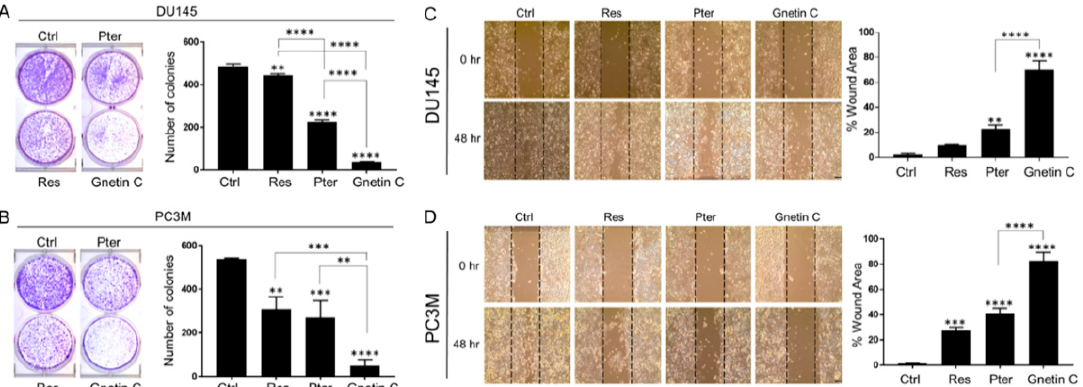
Figure 3. Gnetin C reduces clonogenic survival and motility in DU145 and PC3M prostate cancer cells more potently than Res and Pter. ( A , B ) Representative images ( left ) and quantification ( right ) of the number of colonies showing colony formation ability of prostate cancer cells after treatment with 5 µ M of compounds for 14 days. Data represent the mean ± SEM of three independent experiments with duplicate wells. ** p < 0.01; *** p < 0.001; **** p < 0.0001 (one-way ANOVA). ( C , D ) Representative images ( left ) and quantification ( right ) of the migration ability of cells after treatment with 1 µ M of compounds for 48 h. Values of vehicle-treated Ctrl cells at 0 h were assigned as 100%, and the percentage of wound area of compound-treated cells was calculated on that base. 10X images (scale bar, 100 µ m). Data represent the mean ± SEM of six separate wound areas from three independent experiments. ** p < 0.01; *** p < 0.001; **** p < 0.0001 (one-way ANOVA).